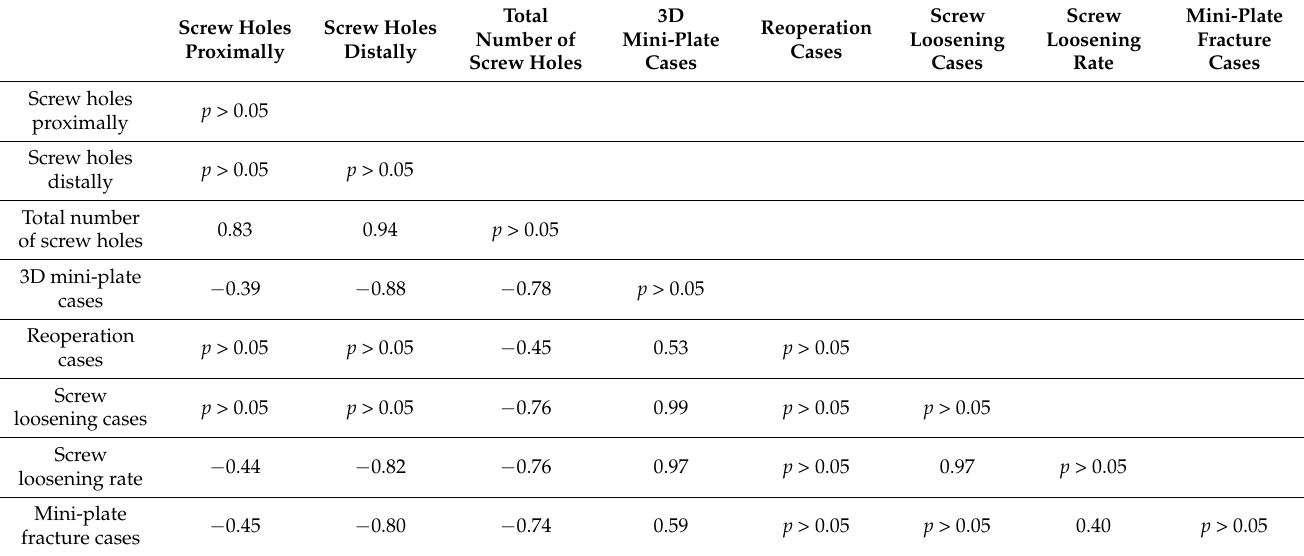
Table 6. Correlation matrix between summarized numerical values for each 3D mini plate shape included in the meta- analysis. Correlation values for data series where Student’s t -test showed p > 0.05 are not reported. Strong correlations, i.e., with an absolute value greater than